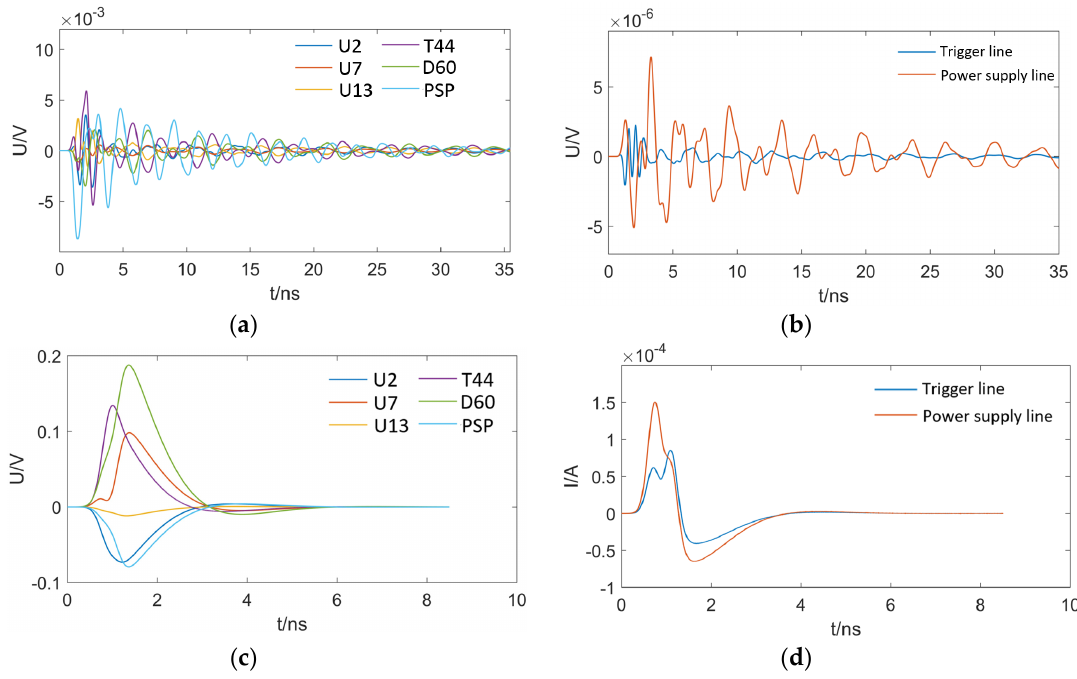
Figure 8. ( a ) Induced voltage under far-field disturbance; ( b ) Induced current under far-field disturbance; ( c ) Induced voltage under near-field disturbance; ( d ) Induced current under near-field disturbance.